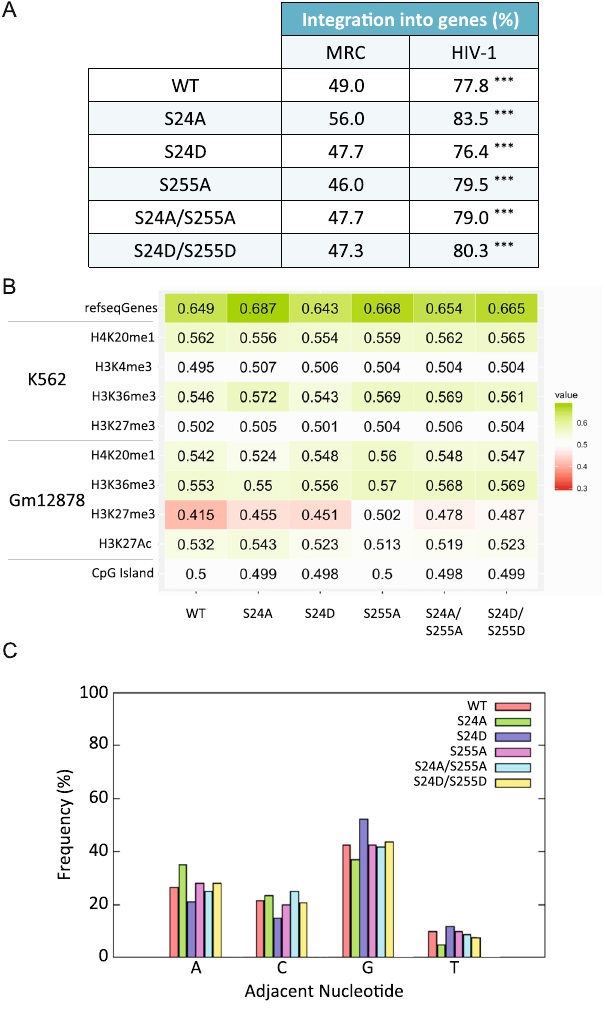
GCN2 − / − MEF cells, compared to GCN2 + / + cells (27.6% of GFP positive cells versus 9.9%). In addition, sequenc- ing of the integration sites obtained in these two cell lines revealed a similar pattern with integration occurring preferentially in the body of genes (data not shown). In parallel, the infectivity of HIV-1 vectors harboring mutations at the IN phosphorylation site in the context of GCN2 + / + MEF cells was tested. In this cellular context, vectors carrying the aspartic acid mutations (S24D, S255D and S24D/S255D) infected the cells similarly to the WT vector with 9.8, 8.2 and 7.5% of EGFP positive cells, respectively. Conversely, an increase in transduction efficiency with viruses harboring the S255A or S24A/ S255A IN mutations (Fig. 9a, left panel) was observed. The proportion of EGFP positive cells was 18 and 19.5% respectively, which is close to the 27.6% observed with the WT vector in the GCN2 − / − cells. This is in agreement with the results obtained using 293 T cells (Fig. 5a) and validates this mouse model. Interestingly, using GCN2 − / − MEF cells led to a diametrically opposite results. In this case, infectivity of mutant vectors carrying IN mutation S255A or S24A/S255A remained comparable to that of the WT lentiviral vector (30.2% and 29.8%, respectively), (Fig. 9b, right panel). But, infectivity of viruses carrying the IN muta- tions S255D and S24D/S255D was decreased in GCN2 − / − MEFs compared to the WT virus. The proportion of EGFP positive cells was 15% and 12.7% respectively, compared to 27.5% for the WT virus in the same cell line. In agreement with this result, the infectivity of the S255D and S24D/S255D vectors in the GCN2 − / − cells was comparable to the infectivity of the WT vector in the GCN2 + / + cells. Thus, in the presence of GCN2, preventing IN phosphorylation with the S255A mutation increased the infectivity at a level similar to that observed in a cell